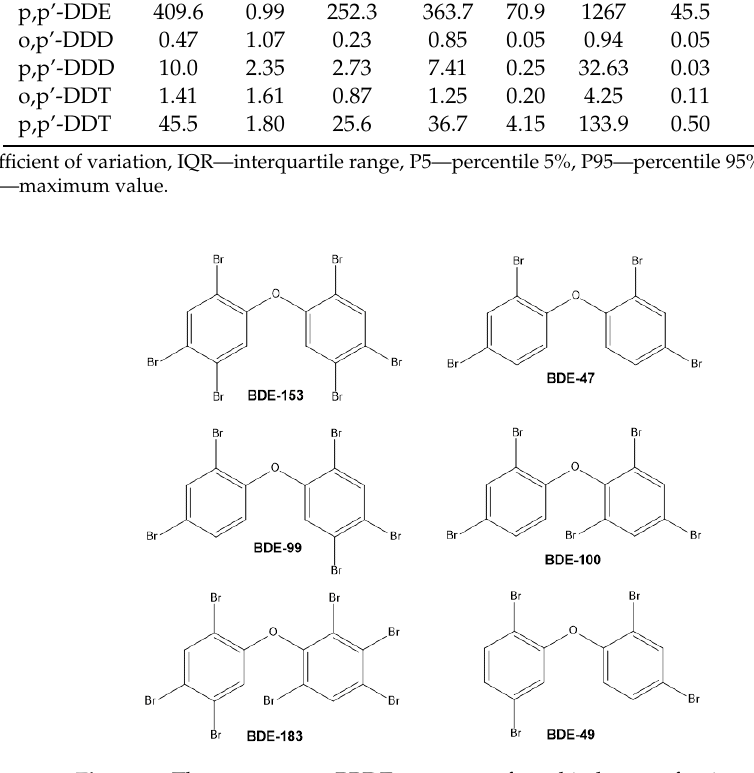
Table 4. Contents of the main PBDEs and organochlorine pollutants in human adipose tissue (ng / g lipid), Geometric means and 95% confidence intervals with lower (LCI) and upper (UCI)